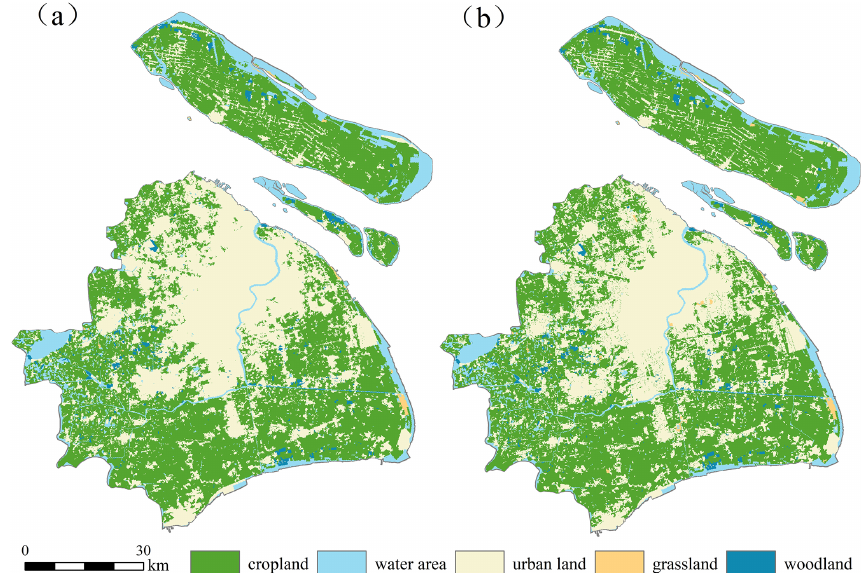
Figure 3. Comparing the simulation results of Shanghai urban expansion with the actual situation: (a) simulation result in 2015 and (b) actual land use in